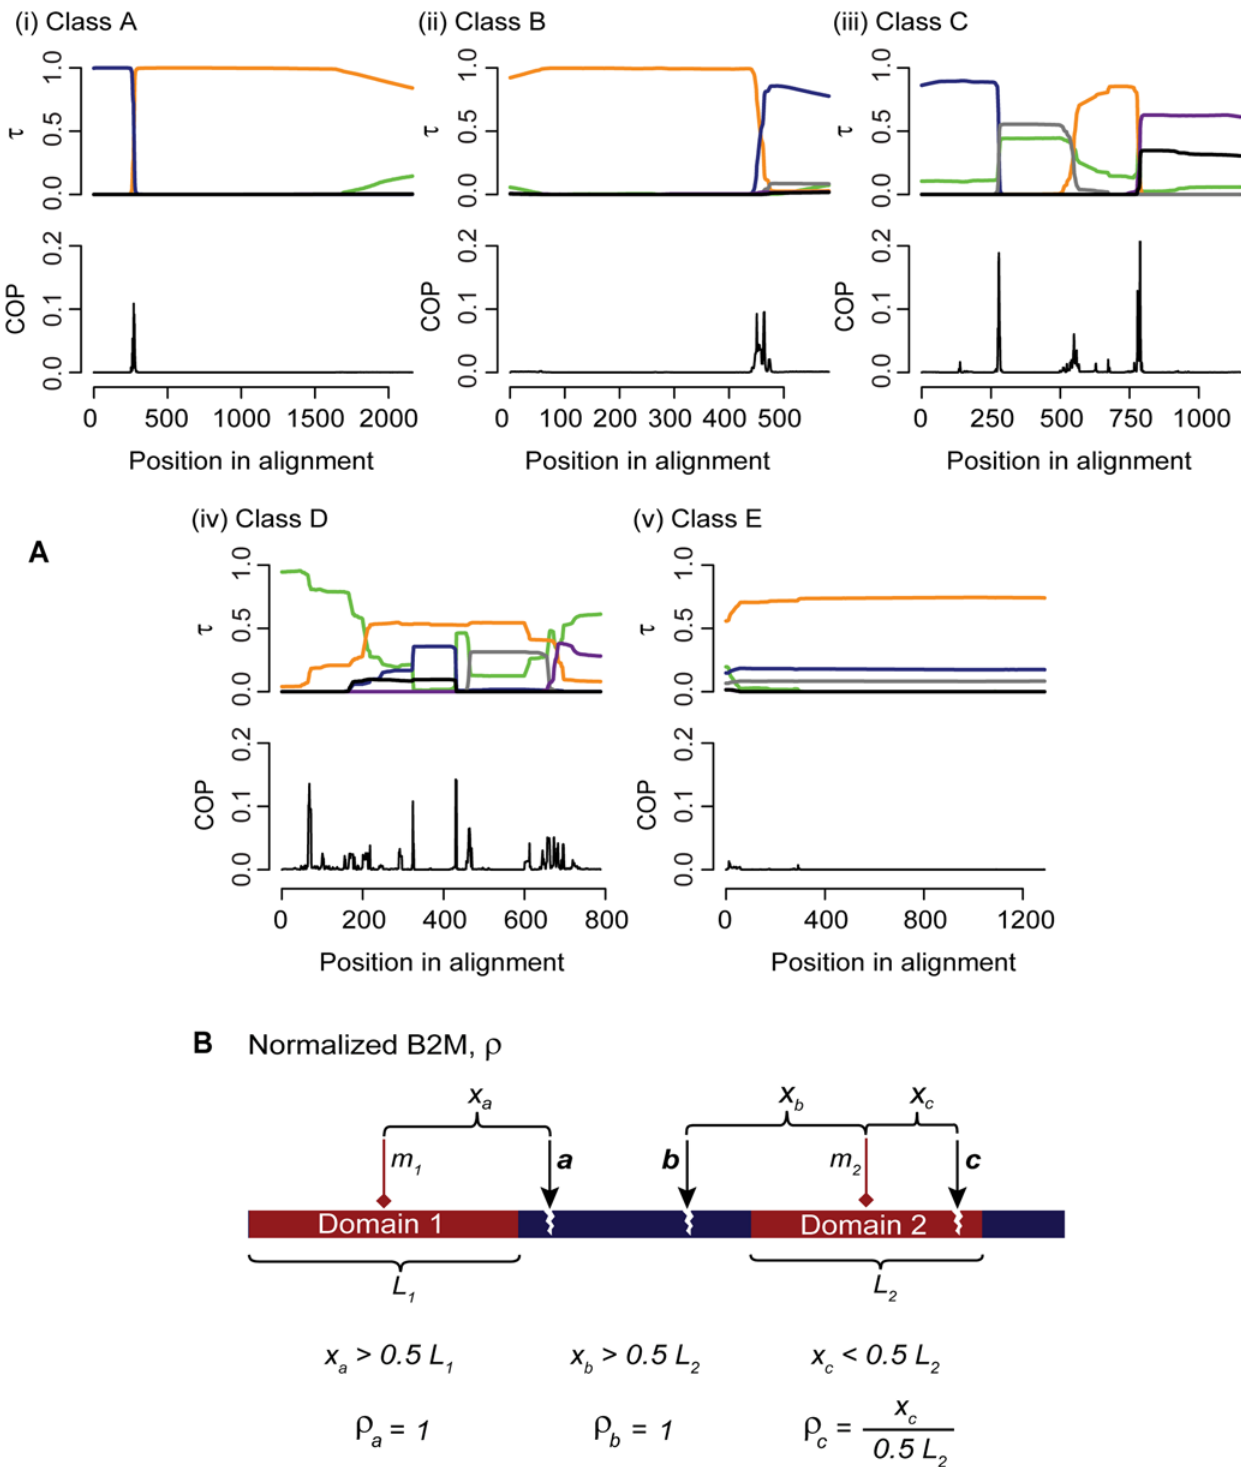
Figure 1. Inference of recombination breakpoints with respect to annotated protein domains. (A) Classification of results in breakpoint identification based on outputs of DualBrothers [25]. In each panel the X-axis represents the positions in the sequence alignment, the Y-axis of the upper graph shows the Bayesian posterior probability ( t ) of the inferred tree topology, and each colored line indicates a distinct topology (five major topologies are shown; the green line represents the sum of remaining tree topologies). The Y-axis of the lower graph in each panel shows the marginal posterior probability that an alignment position (column) is a breakpoint. Examples are shown for each of classes A–E. Classes A–C present clear evidence of recombination, Class D contains inconclusive cases, and Class E consists of cases for which we find no evidence of recombination. (B) Definition of r . A protein sequence is illustrated with two predicted domains. The midpoint of each domain is represented by a red diamond ( m 1 and m 2 ). Three breakpoints ( a–c ) are illustrated as black arrows. The r denotes the number of amino acids between an observed breakpoint and the midpoint of the nearest domain, divided by the half-length of the corresponding domain (0.5 L ), with r max =1 (where the breakpoint is located at or outside the domon boundary in an aligned gene-sequence set). doi:10.1371/journal.pone.0004524.g001 PLoS ONE |